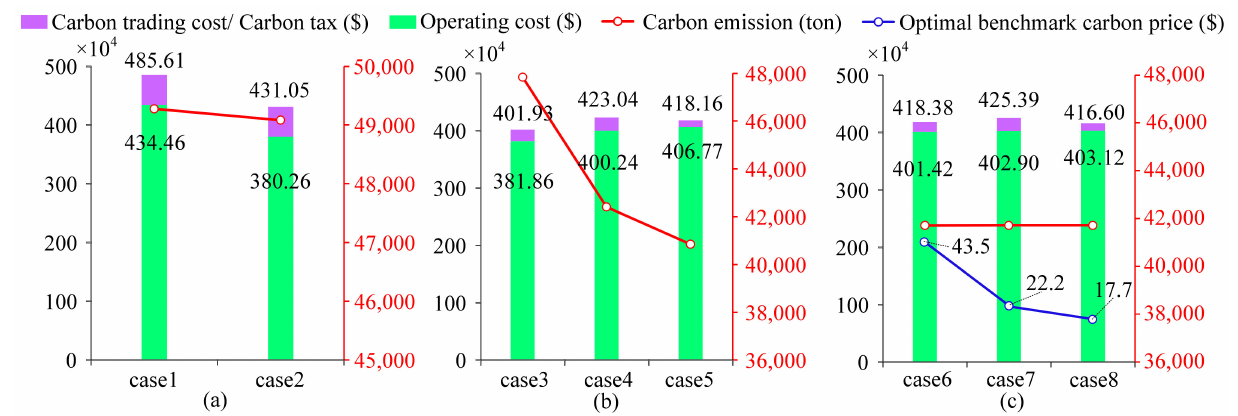
Figure 9. Dispatching results of each